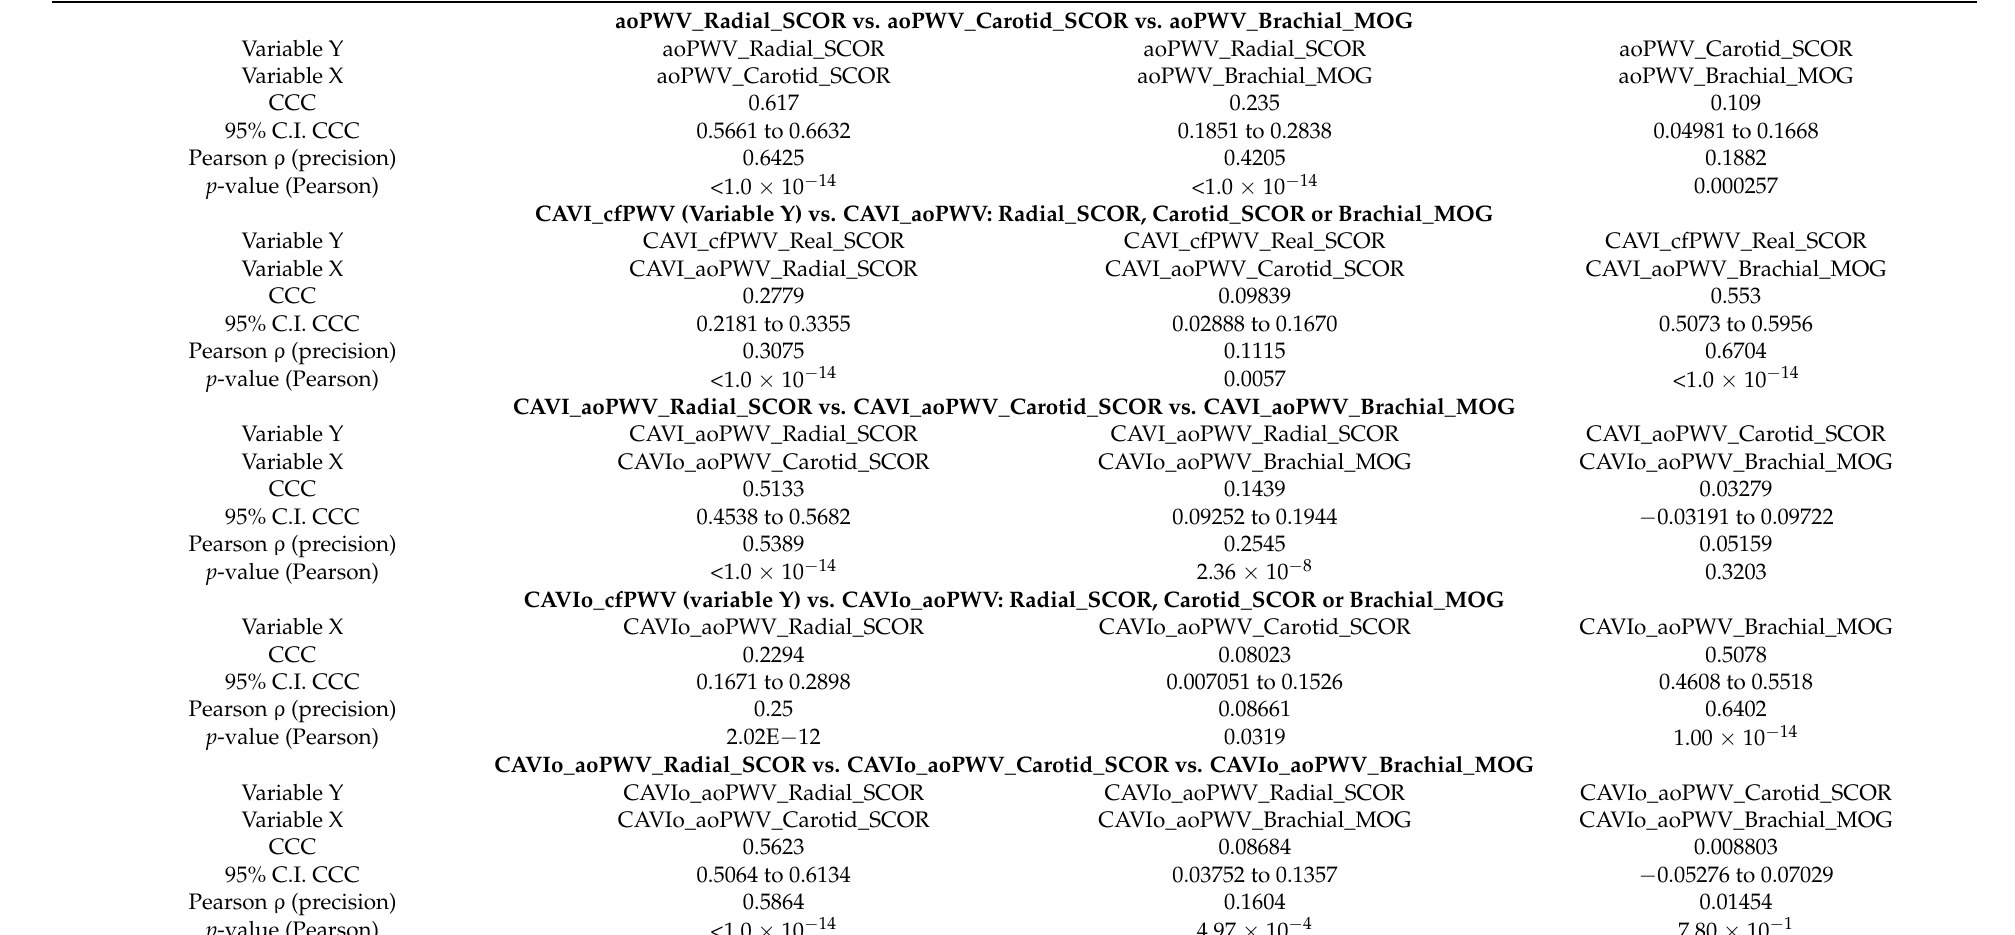
CCC: concordance correlation coefficient. C.I.: confidence